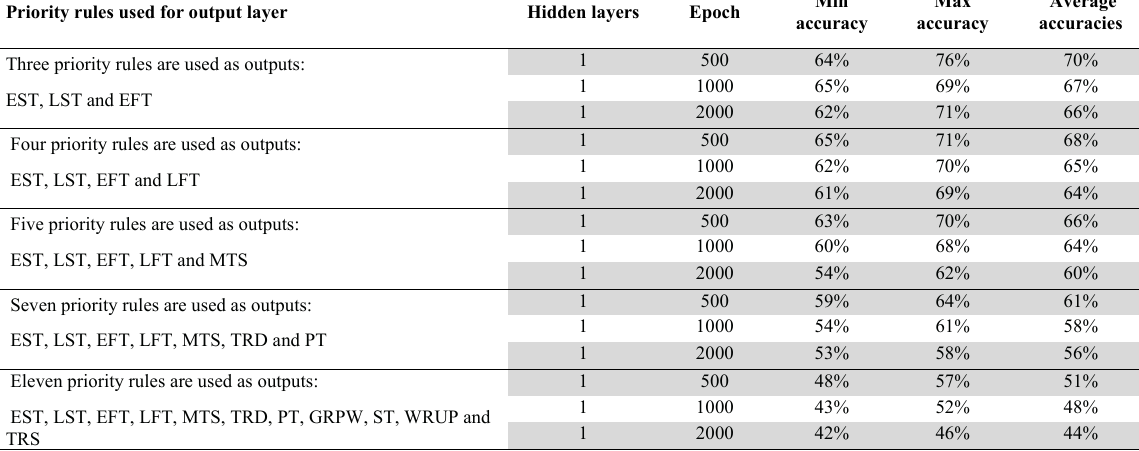
Training performance of developed MLFNN with one hidden layer Priority rules used for output layer Hidden layers Epoch